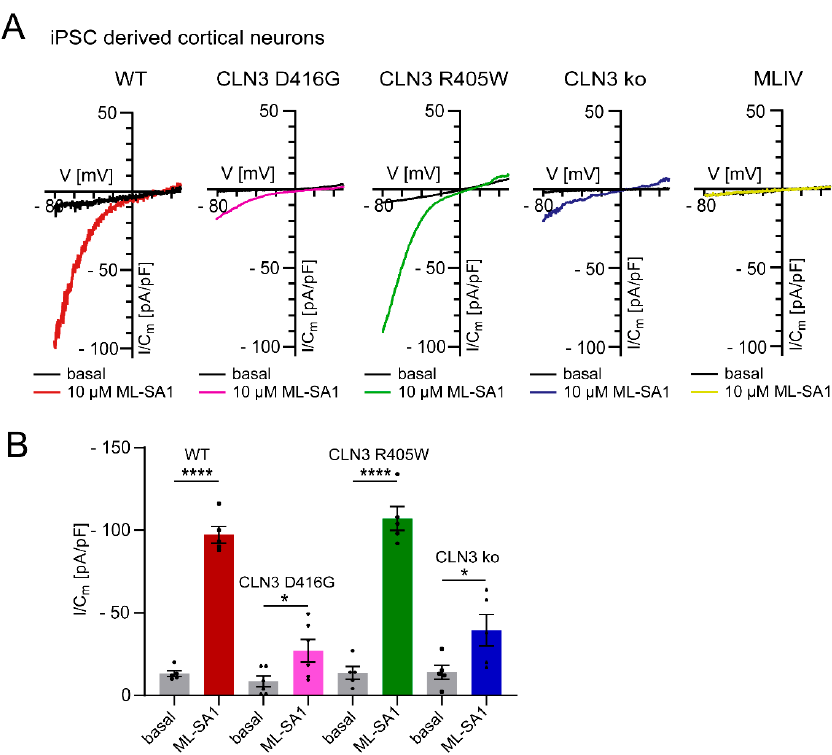
Figure 4. Effect of TRPML1 activation in different LSD and WT iPSC-derived cortical neurons (endolysosomal patch clamp experiments as described previously [12]). ( A ) Representative measurements (I/Cm -V traces) from apilimod-enlarged LE/LY, isolated from WT, CLN mutants or MLIV knockout iPSC derived cortical neurons activated with ML-SA1 (10 µM). ( B ) Statistical analysis of TRPML1 activation at − 80 mV depicted as mean values ± SEM (WT, CLN D416G, CLN R405R or CLN ko; n > 5); each dot represents a single measurement from distinct neuronal differentiations. An unpaired t-test was applied to quantify statistical significance; * p -value < 0.05, **** p -value < 0.0001.